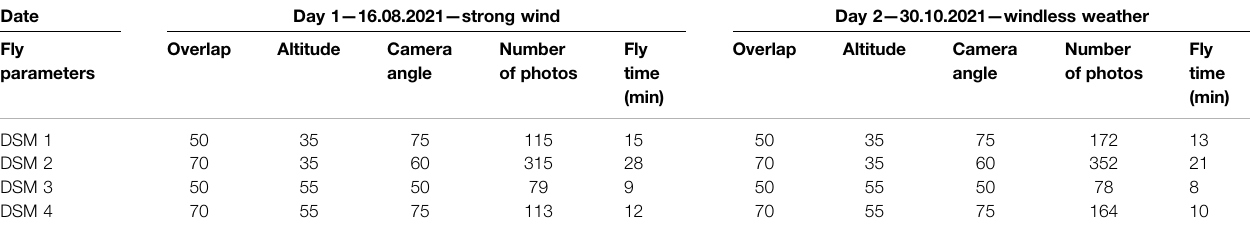
TABLE 1 | UAV Input parameters, dates of fl ights, time and number of photographs